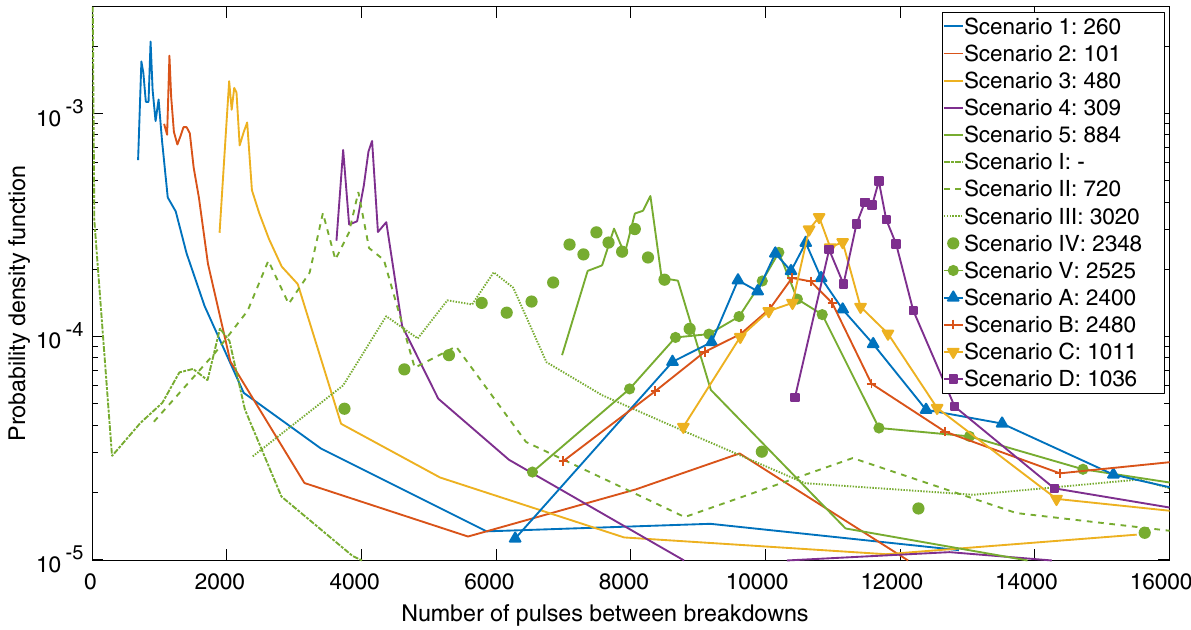
FIG. 3. Probability density function for a BD to occur at a number of pulses after the previous BD event for the different voltage recovery scenarios. The number in the legend after each scenario shows the full width at half maximum value for the peak (in